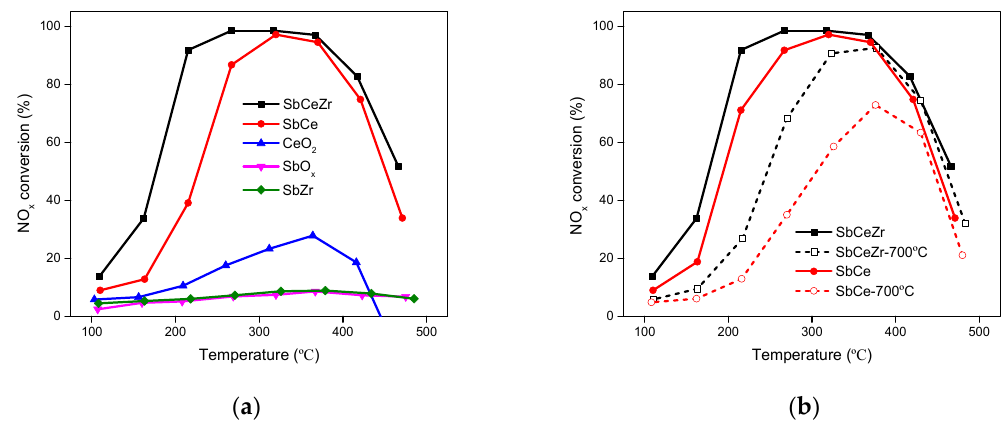
Figure 1. ( a ) NO x conversions and ( b ) thermal stability over the catalysts (reaction conditions: 500 ppm NO, 500 ppm NH 3 , 5% O 2 , with Ar balance).